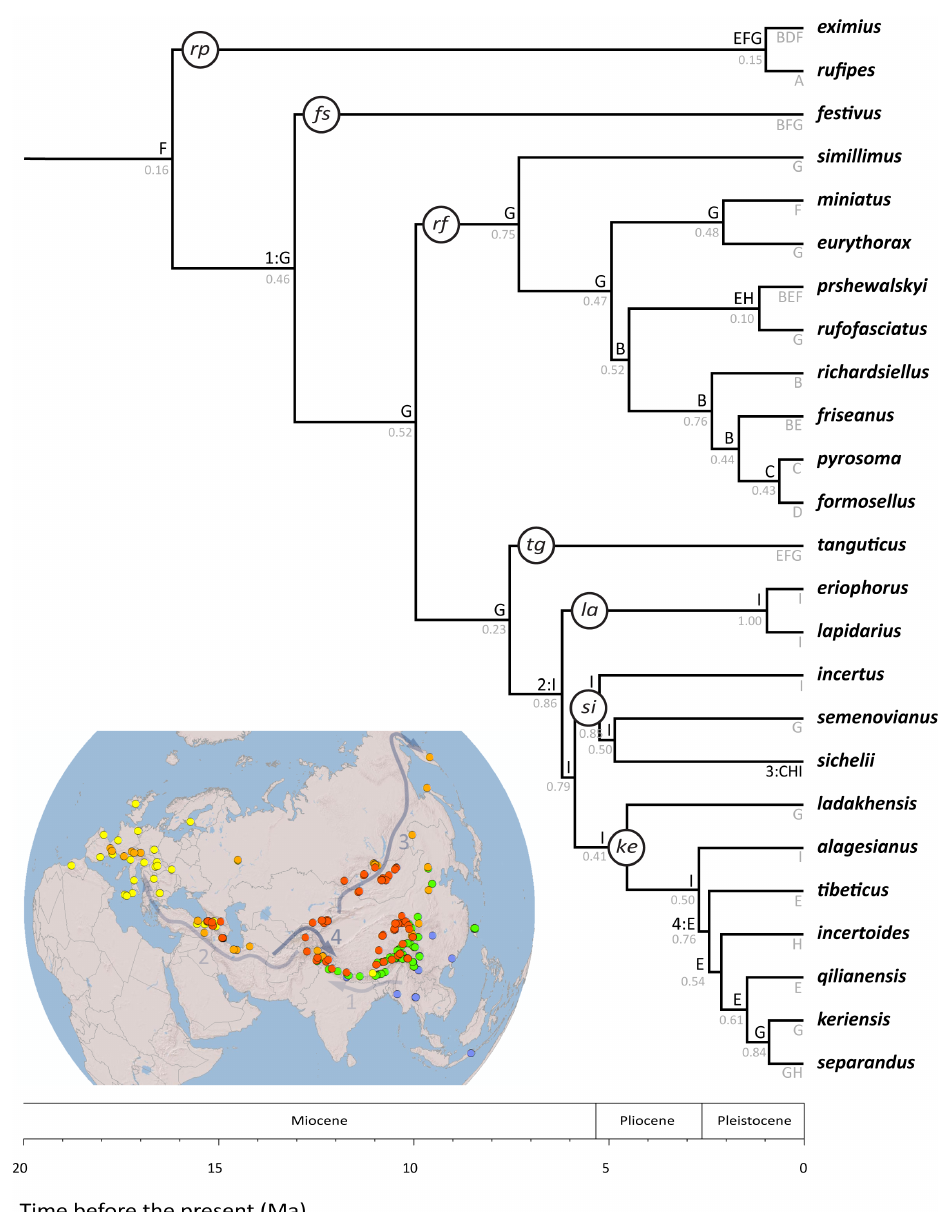
Fig. 24. ( Most likely ancestral ranges for lineages of the subgenus Melanobombus von Dalla Torre, 1880. reconstructed with DIVALIKE+J (BioGeoBEARS) using the short-distance dispersal (no jumps) model in Fig. 23, the estimate of species phylogeny in Fig. 22, and with B. nobilis representing the outgroup (not shown). Letters represent the area units defined in Table 5 and in Fig. 23: letter combinations in grey below terminals show species’ current distributions; letter combinations above the nodes show the most likely reconstructions for ancestral distributions (with four selected dispersal events numbered), with the probabilities of these solutions for these ancestors shown below the nodes. Species groups discussed in the text are labelled in circles: rp = rufipes -group; fs = festivus -group; rf = rufofasciatus - group; tg = tanguticus -group; la = lapidarius -group; si = sichelii -group; and ke = keriensis -group. Inset map shows sequenced samples for the species groups (blue = the rufipes -group and festivus -group; green = the rufofasciatus -group; yellow = the tanguticus -group and lapidarius -group; orange = the sichelii -group; and red = the keriensis -group) with arrows showing the four numbered dispersal